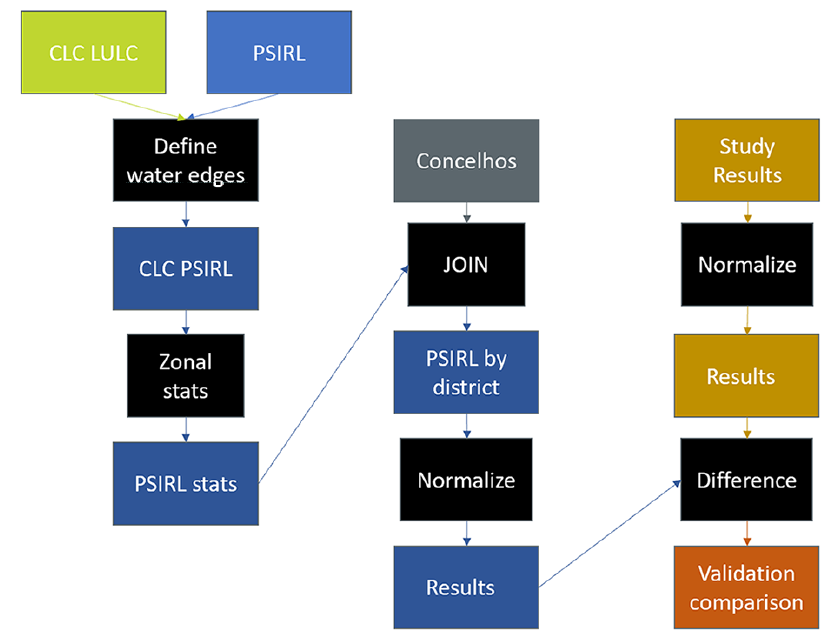
Figure 3. Pollination Suitability Index for Riverine Landscapes (PSIRL) validation flow.